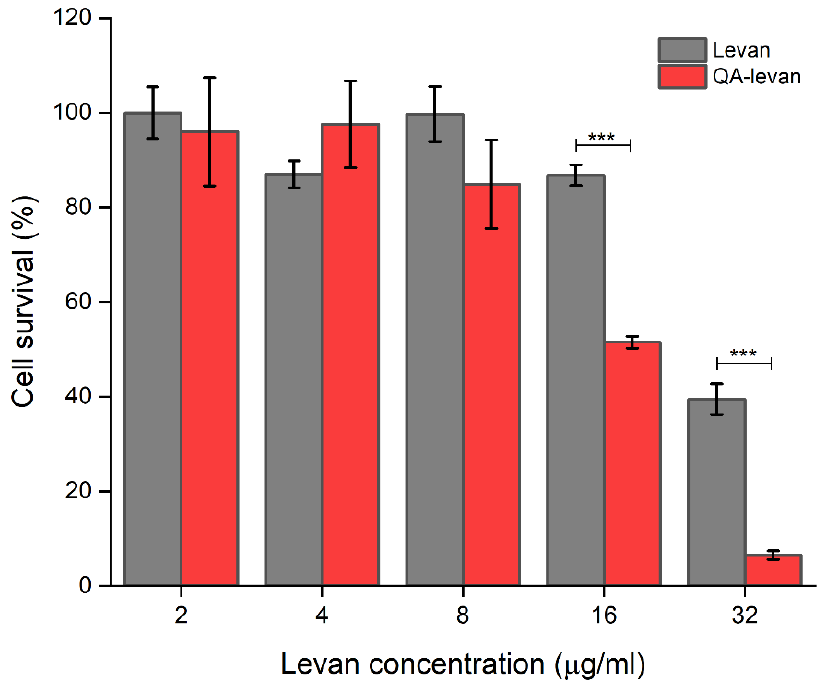
Figure 6. Cytotoxicity of native levan and QA-levan toward HEK293 cells measured by MTT assay. Each data point is presented as mean ± SEM (*** p < 0.001 vs. control).